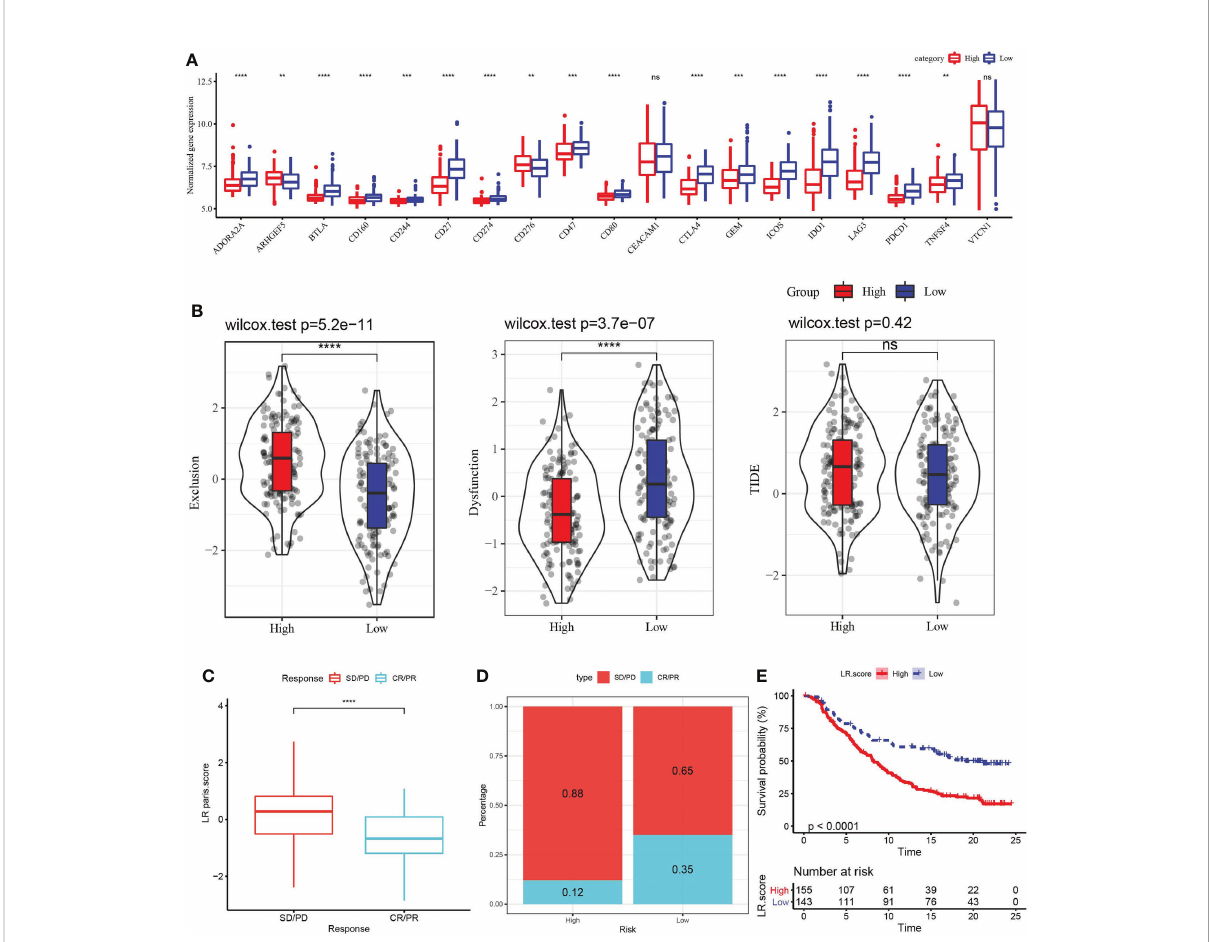
FIGURE 8 Evaluation of the relationship between LR pairs score model and ICI treatment. (A) The association between LR pairs score and gene expression of immune checkpoints, Wilcoxon test. (B) The correlation between LR pairs score model and exclusion score, dysfunction score and TIDE score predicted by TIDE method, Wilcoxon test. (C) LR pairs score statistical difference between complete response (CR)/partial response (PR) group and stable disease (PD)/progressive disease (PD) group in IMvigor210 cohort. (D) The survival curve of different LR pairs score groups in the IMvigor210 cohort. (E) Response to anti-PD-L1 treatment in patients with different LR pairs score in the IMvigor210 cohort, Log rank test. The asterisks represented the statistical p value, ns(no signi fi cance) **p < 0.01, ***p < 0.001, ****p <